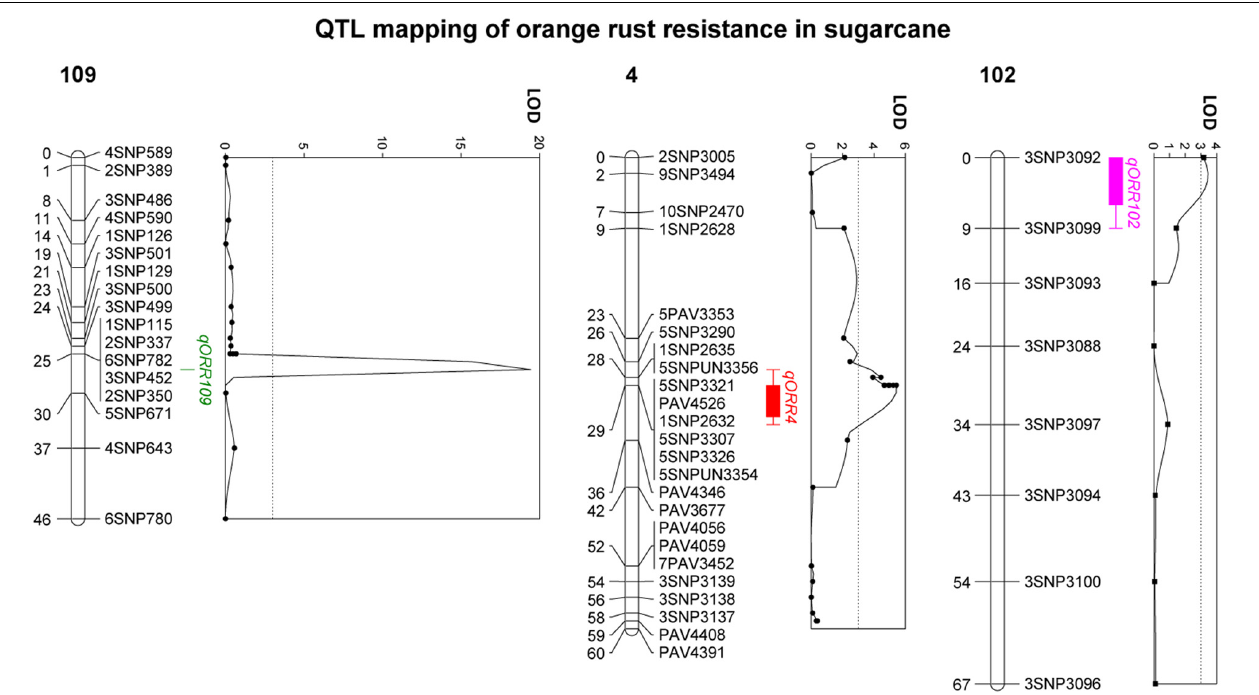
FIGURE 2 | Logarithm of odds (LOD) score plots of the quantitative trait loci (QTLs) for sugarcane orange rust resistance in the regions harboring the three identified QTL clusters.